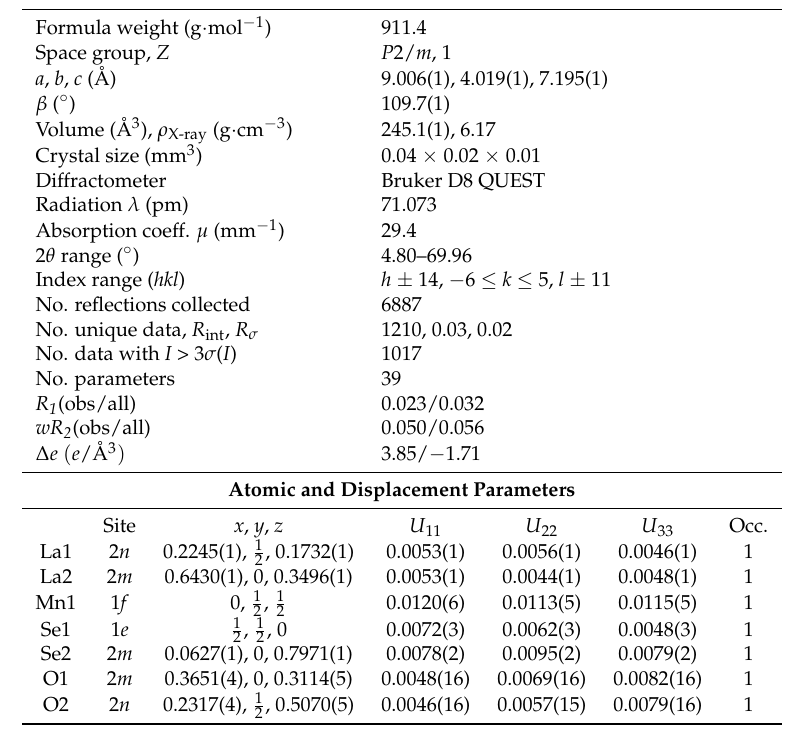
Table A2. Crystallographic data of La 4 MnSe 3 O 4 .